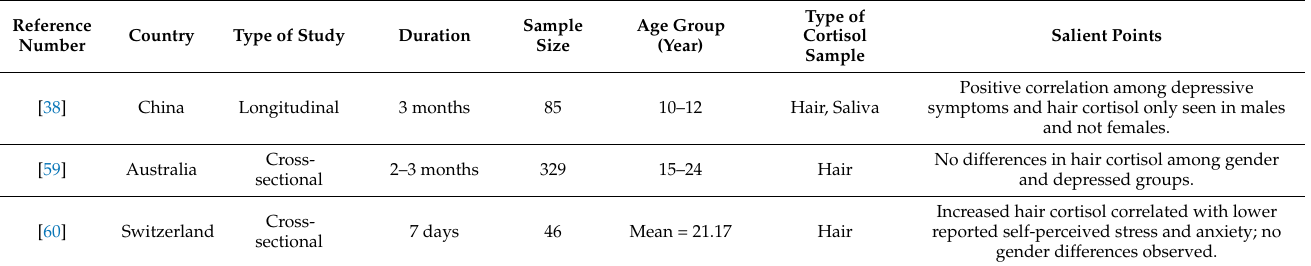
Table 4. Hair follicle mixed-gender studies investigating the relationship between cortisol and depression.